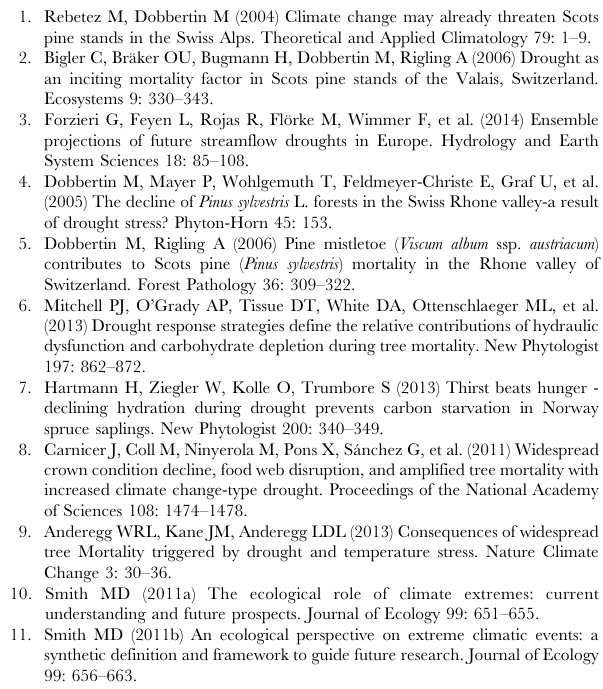
Table S1 Translation and specified classification for the indicator values by Landolt (1977). Table S2 Species list with the mean abundance (%) in the control and irrigated plots. One-way ANOVA: p ,